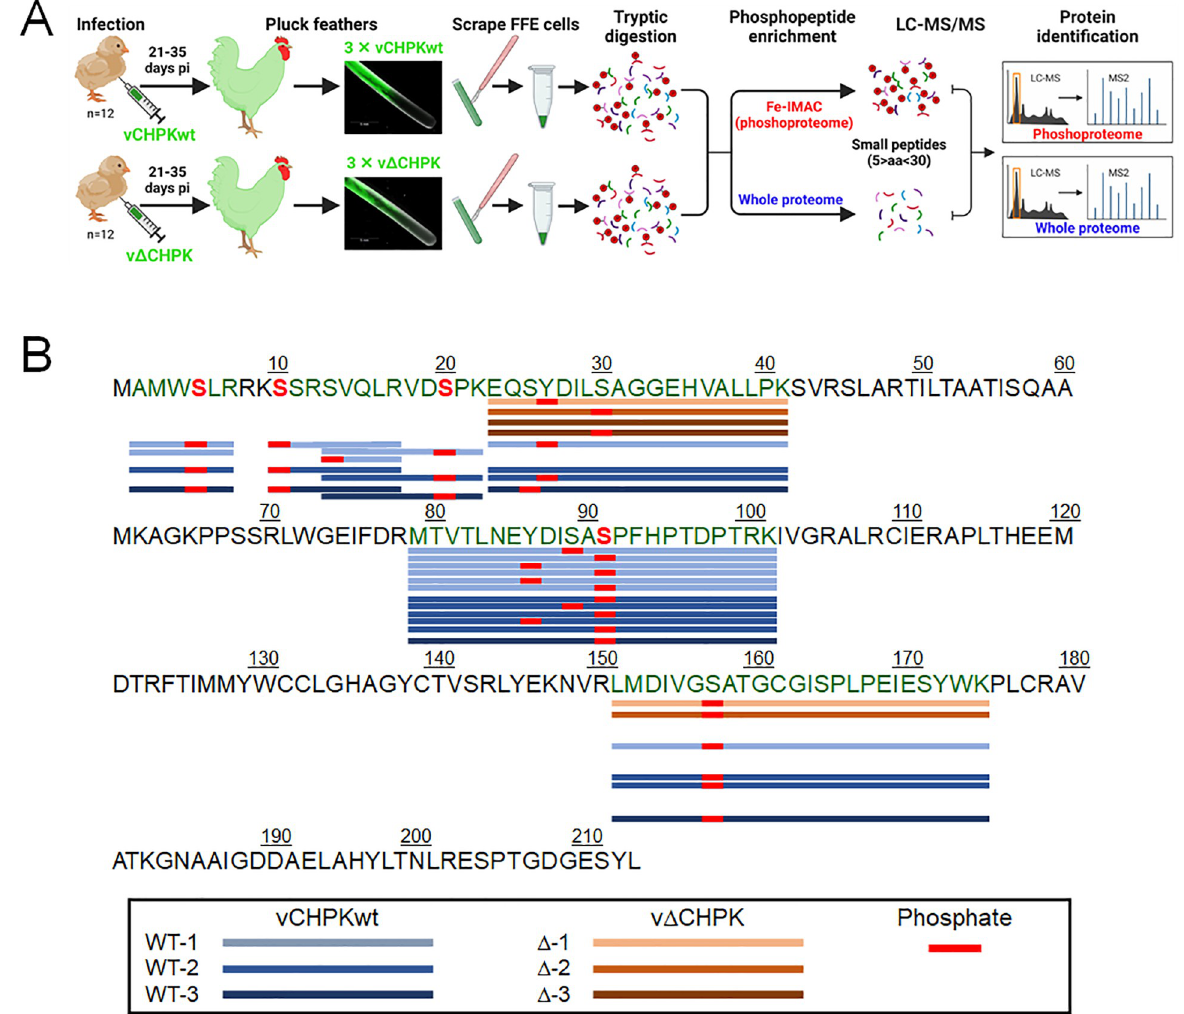
Fig 7. pCHPK targets pUS10 in chicken epithelial skin cells. (A) Flow chart created with BioRender.com of the experimental plan to perform MS-based proteomics on infected FFE skin cells scraped from chickens infected with vCHPKwt/10HA or v Δ CHPK/10HA and prepared for LC-MS/MS-based proteomics. Some sample was used to identify the viral proteome and some protein was used for phosphopeptide enrichment. (B) The protein sequence of MDV pUS10 with peptides identified in the three replicates of vCHPKwt- (WT) and v Δ CHPK- infected FFE cells that were phosphorylated. Serines phosphorylated in only vCHPKwt (3/3) and absent in v Δ CHPK (0/3) samples are indicated as a red (S), including S5, S10, S20, and S91.